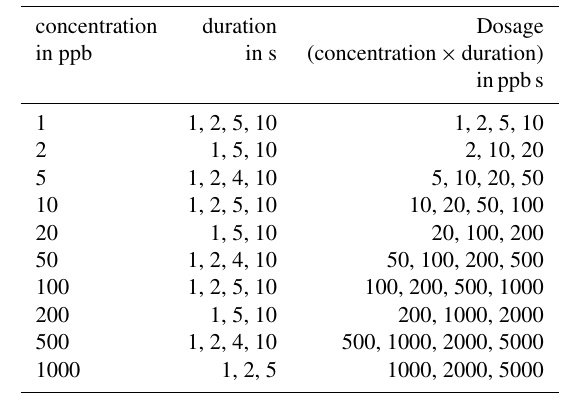
Figure 6. Conductance curve in the low temperature plateau in clean air (black dashed line). At 300s in the cycle a 4s peak with 5ppb ethanol was offered (black solid line). The grey line is the calculated rate constant of ethanol.